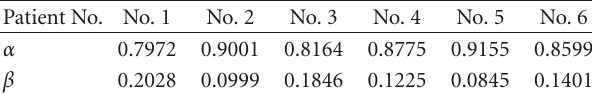
Table 1: The optimal parameters α and β for six patients Patient No. No. 1